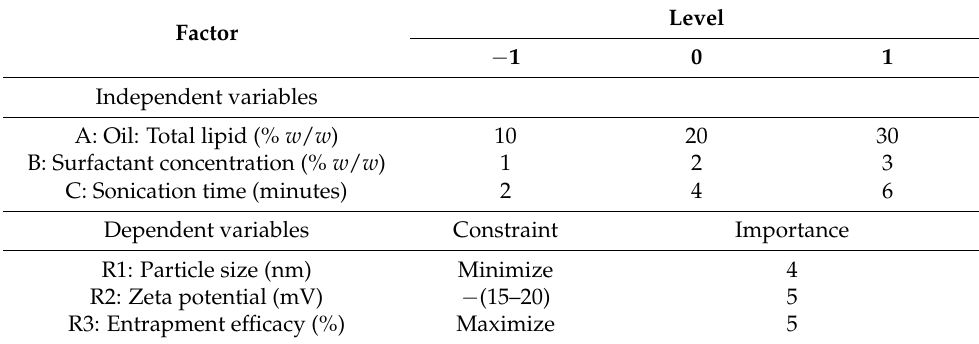
Table 1. NIC–NLC formulation variables with different levels in a Box–Behnken